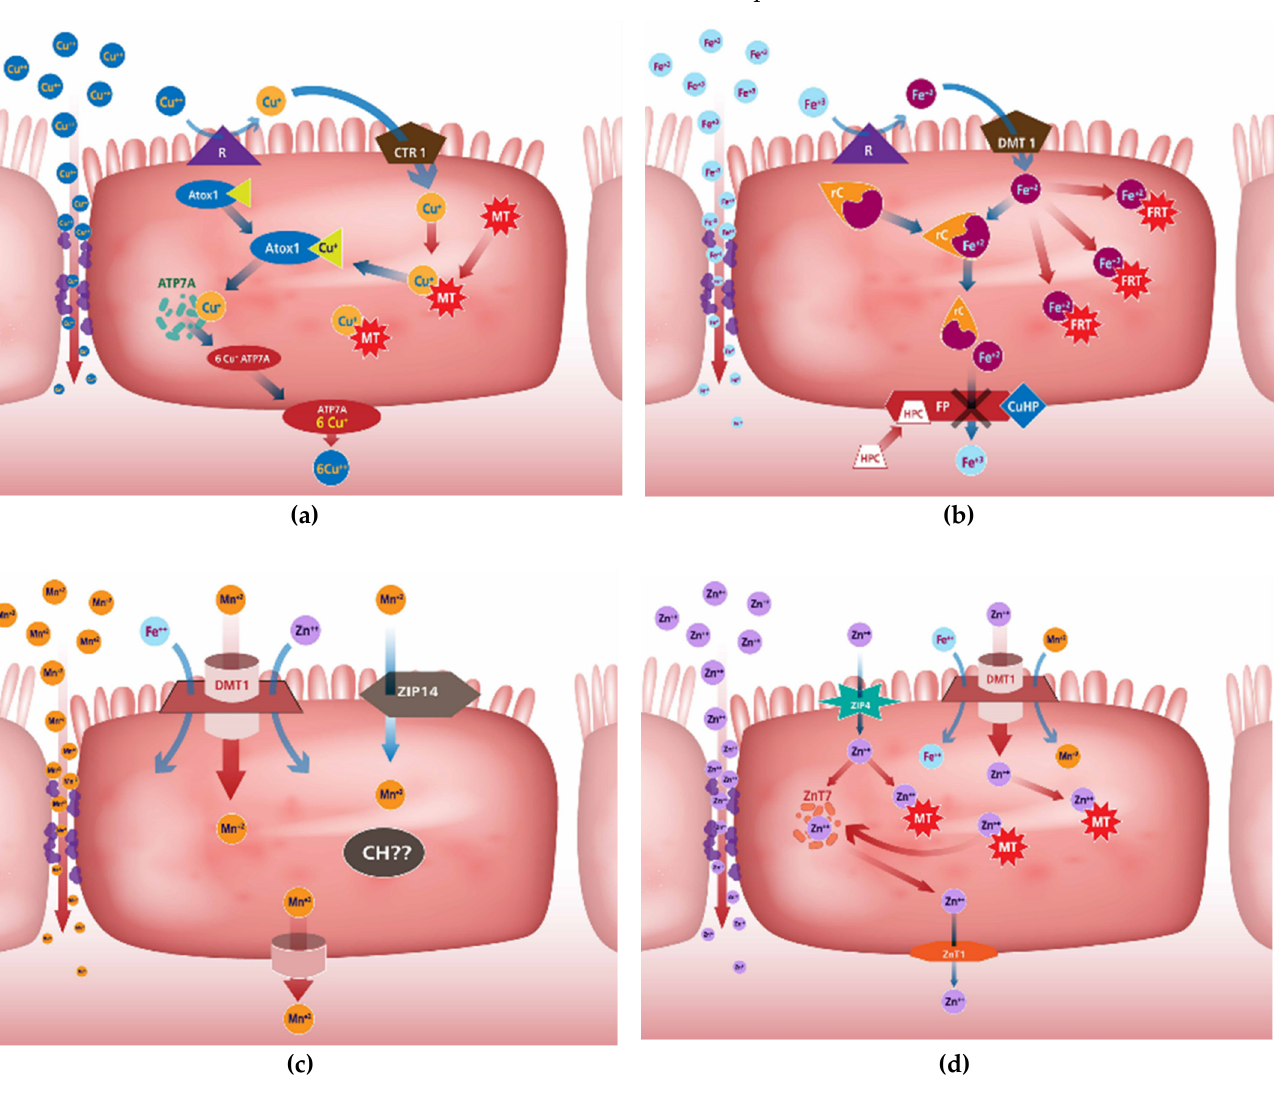
Figure 1. Cu ( a ), Fe ( b) , Mn ( c ) and Zn ( d ) trace mineral uptake mechanisms at adequate mineral status. Adapted from Goff [67].